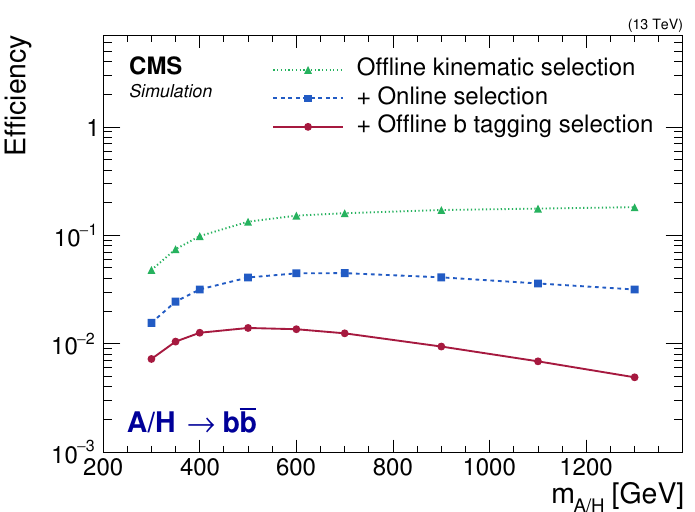
Figure 2 . Signal e(cid:14)ciency as a function of the Higgs boson mass after di(cid:11)erent stages of event selection.